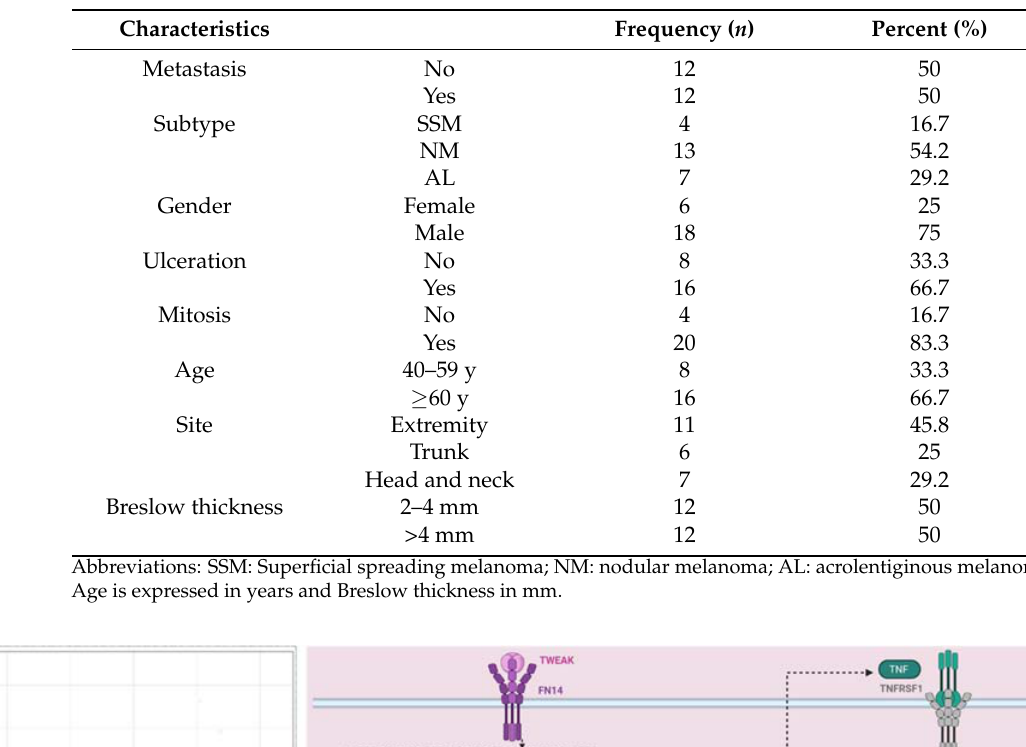
Table 1. Clinical and histopathological parameters of all patients with thick CM.